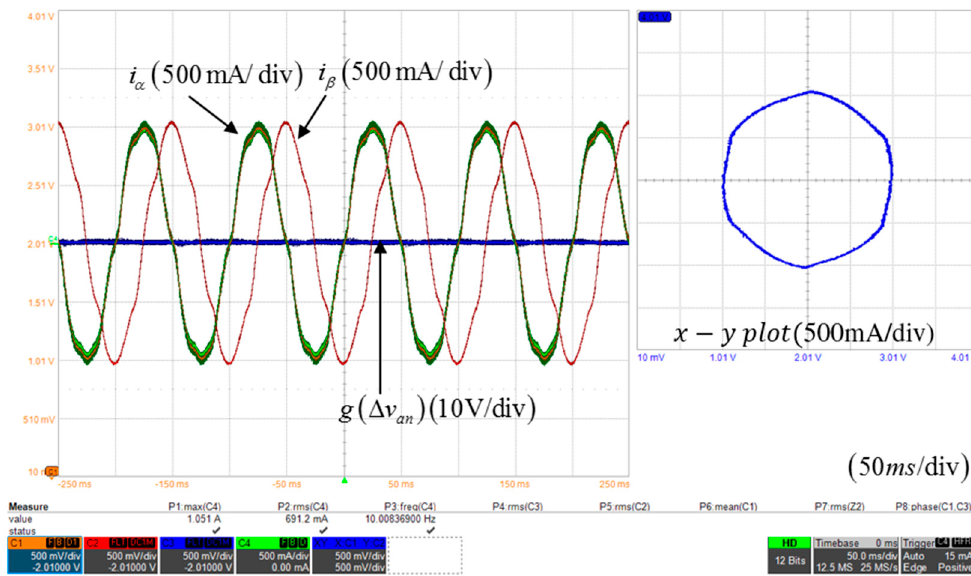
Figure 27. Stationary reference frame α − β axis and on the x-y plot current waveforms with Figure 23.